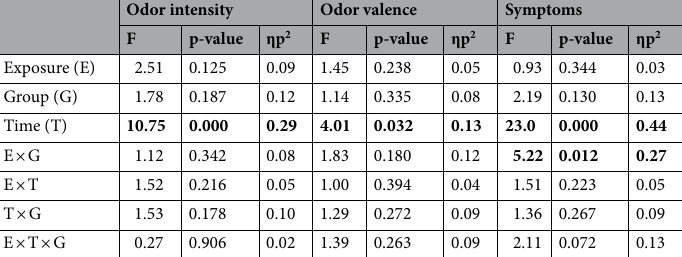
Table 4. Results from the three-way ANOVAs for odor intensity and valence and symptoms (F-values and, if statistically significant, ηp 2 values within brackets) with three groups (Referents/BRS/BRS + CI). Significant values are in